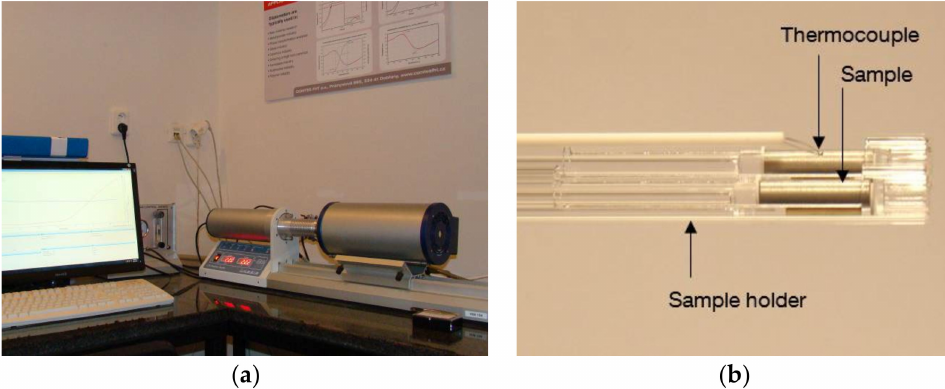
Figure 6. ( a ) Dilatometer set up. ( b ) Sample holding